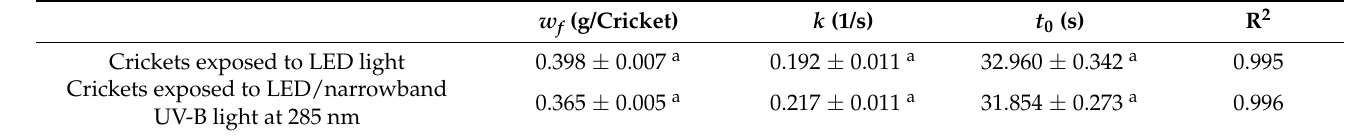
Table 1. Estimates of the parameters of Equation (3) (individual weight as a function of rearing time) that were applied to the average data obtained from the cricket Acheta domestica rearing with the two irradiation